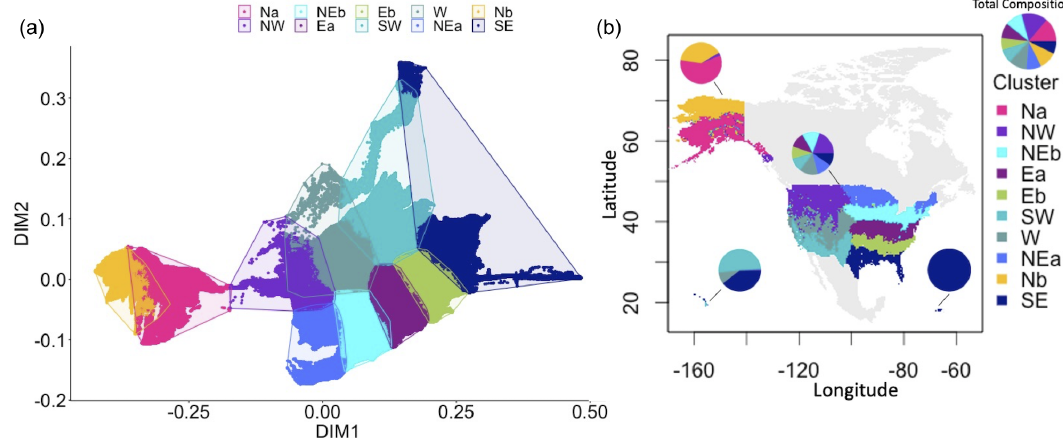
Figure 2. (a) Multidimensional scaling across the United States (US) produced 10 clusters using ecotype (Table 1), climate, and location (latitude/longitude). (b) Spatial distribution of the identified clusters.